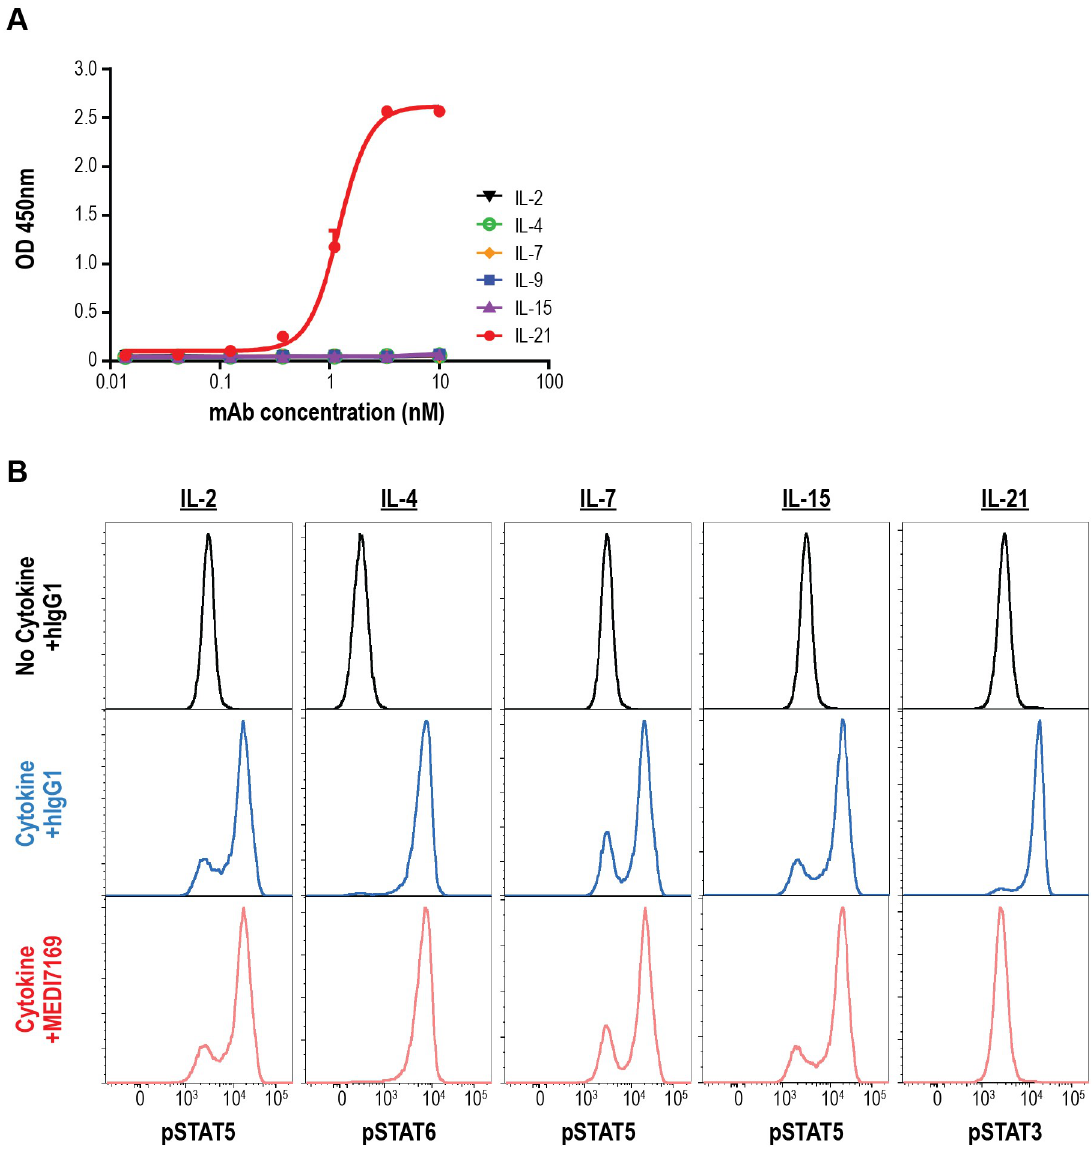
Fig 8. MEDI7169 binding specificity and neutralization of IL-21. (A) The binding specificity of MEDI7169 to common γ c cytokines (IL-2, IL-4, IL-7, IL-9, IL-15, and IL-21) was evaluated by ELISA. Samples were tested in duplicate wells. Values are expressed as mean ± standard deviation. (B) Human PBMCs were stimulated with recombinant human IL-2, IL-4, IL7, IL-15, or IL-21 in the presence of MEDI7169 or human IgG1 control antibody. Cytokine-induced phosphorylation of STAT molecules appropriate for each cytokine was assessed by flow cytometry. Induction of STAT phosphorylation signalling in the presence of MEDI7169 or human IgG1 is shown for each cytokine vs no cytokine control. All conditions were run in duplicate. Results from 1 of 2 representative donors are shown. OD = optical